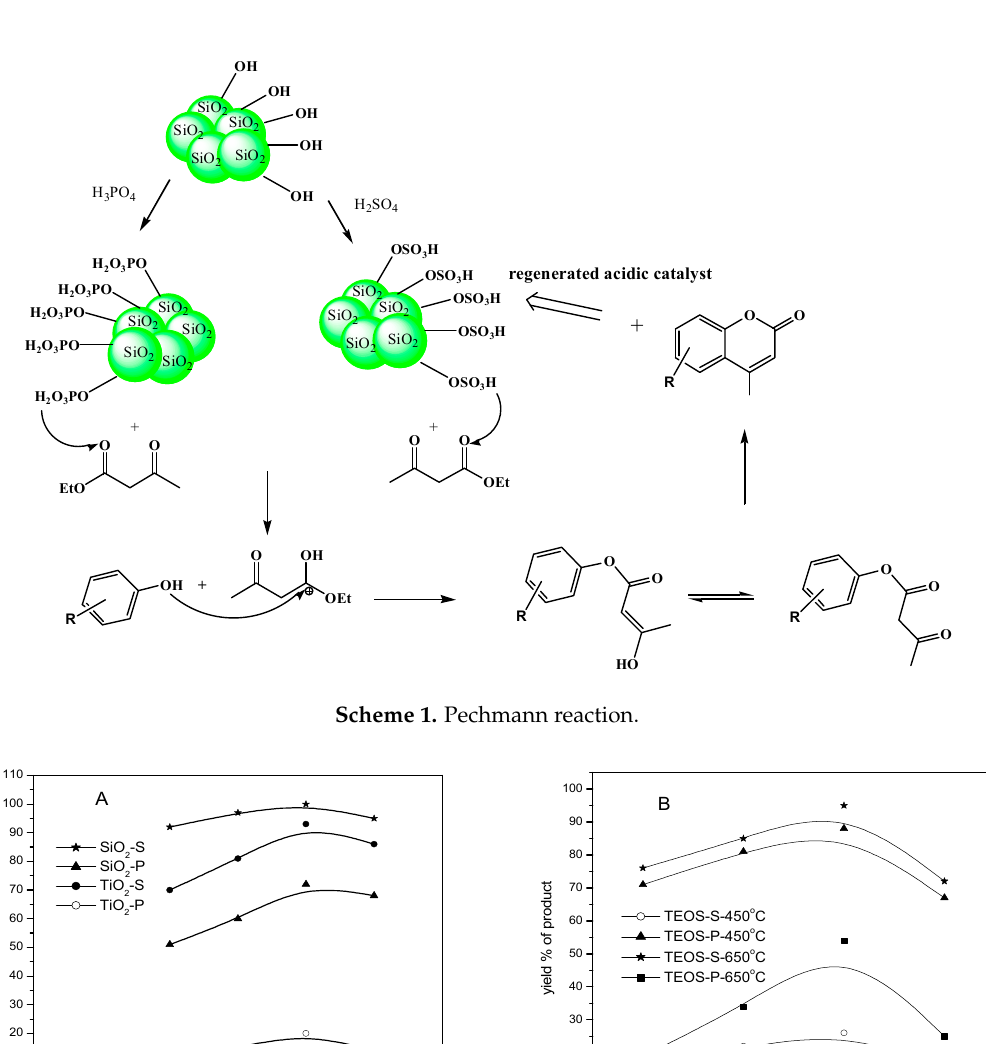
Figure 8. Effect of weight catalysts on yield % of product for reaction of resorcinol and ethyl acetoacetate at reaction time 4 h. Plot ( A ) sulfated and phosphate silica and titania; plot ( B ) silica prepared from TEOS treated with sulfuric and phosphoric acid calcined at 450 and 650 °C.